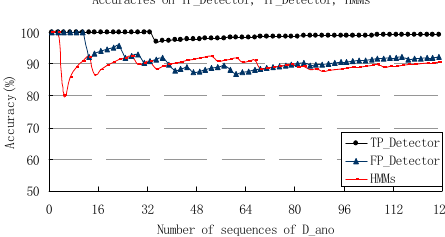
Fig. 2 Accuracy changes of TP-Detector , FP- Detector and HMMs with increasing sequences on D_Ano . The same test data were used for three algorithms, but their accuracy changes were obvious different. Along 128 tested sequences, TP-Detector failed only once located on the 35 th ; FP-Detector failed ten times located on the 13 th , 25 th , 30 th , 38 th , 39 th , 46 th , 58 th , 81 th , 85 th and 116 th ; HMMs failed twelve times located on the 5 th , 14 th , 29 th , 35 th , 55 h , 63 th , 68 th , 69 th , 80 th , 84 th , 89 th and 109 th .